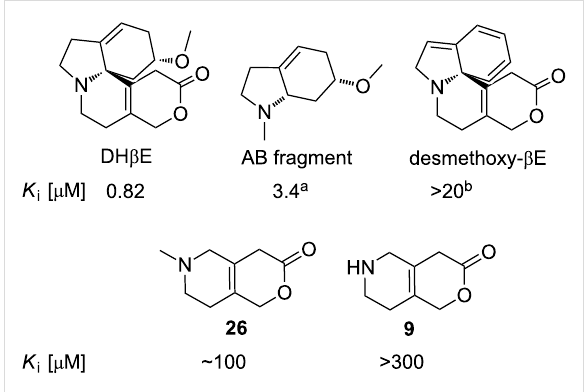
Figure 2: The binding affinities of compounds 9 and 26 at the rat α 4 β 2 nAChR. a) The AB fragment was evaluated in a [ 3 H]-epibatidine binding assay [3]. b) Desmethoxy- β E was evaluated by Wildeboer in a [ 3 H]-cytisine binding assay